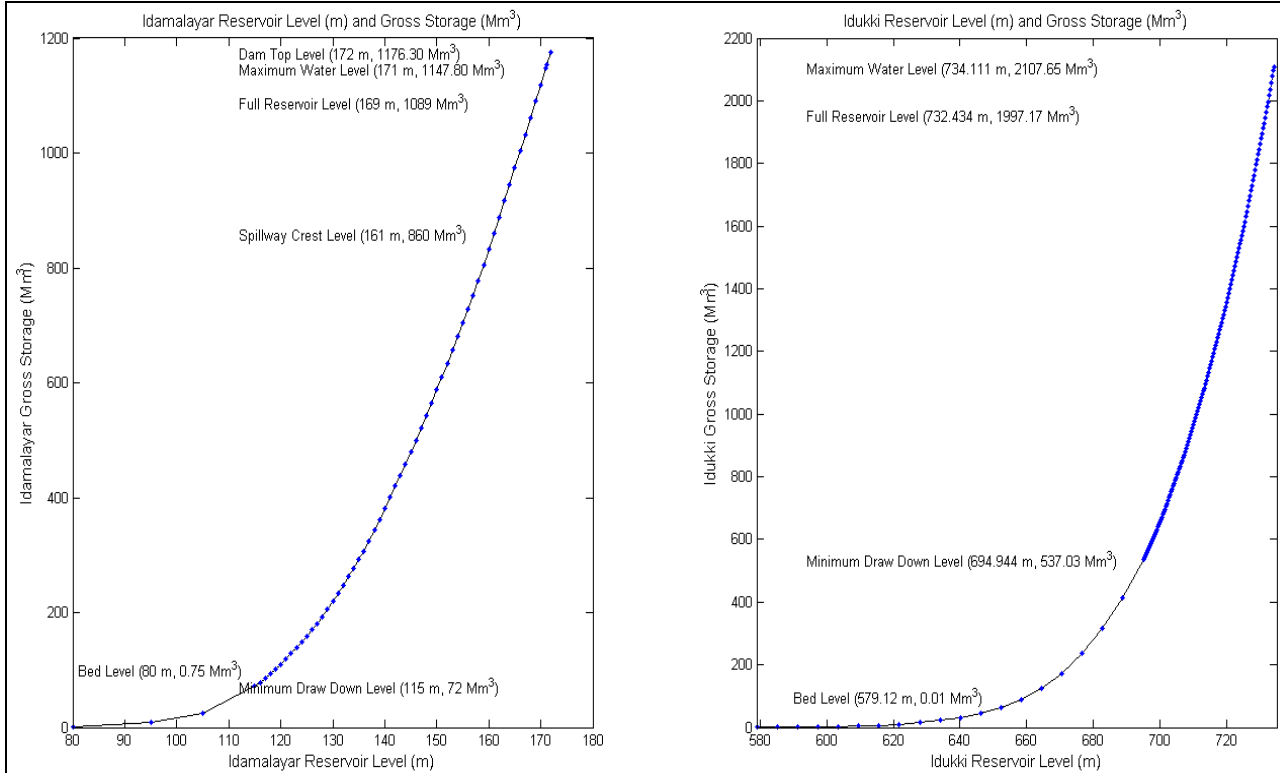
Figure 5. Idamalyar and Idukki level and gross storage relationship.